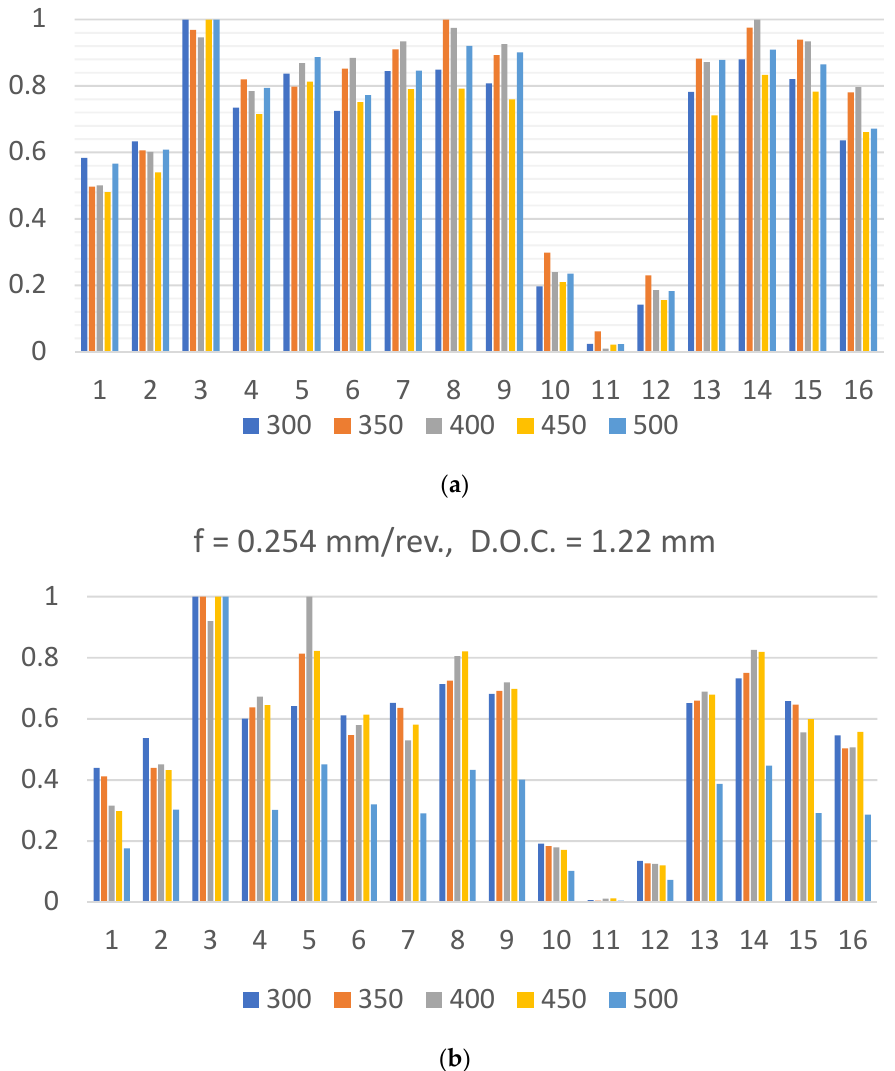
Figure 3. Sample FFT averaged 16 bands for a feed rate = 0.254 mm/rev, and for different speeds at: ( a ) D.O.C. = 0.84 mm, and ( b ) D.O.C. = 1.22 mm.